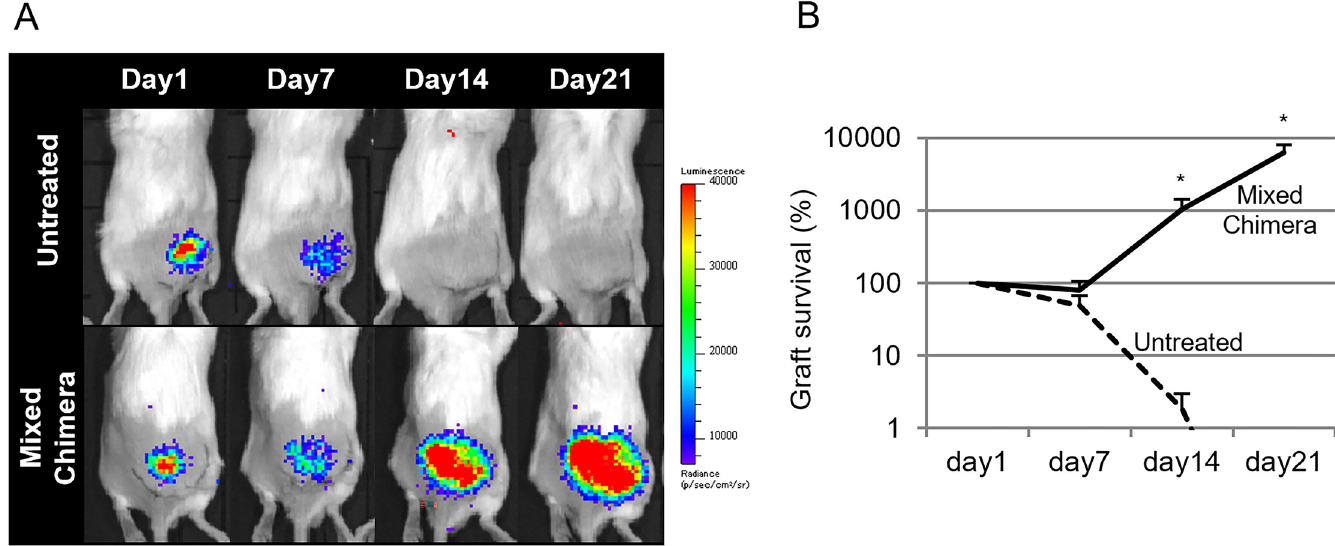
Fig 3. In vivo imaging of bioluminescence. (A) Representative images of luciferase transgenic allogeneic induced pluripotent stem cell-derived cardiomyocyte (iPSC-CM) sheets transplanted in normal untreated BALB/c mice or mixed-chimera BALB/c mice, obtained through in vivo imaging on days 1, 7, 14, and 21 post transplantation. (B) Percentages of the bioluminescence signal on days 7, 14, and 21 compared to those on day 1 post transplantation in normal untreated BALB/c mice or mixed-chimera BALB/c mice. Student’s t -test was performed, and the results are presented as mean ± SEM. � P < 0.05.